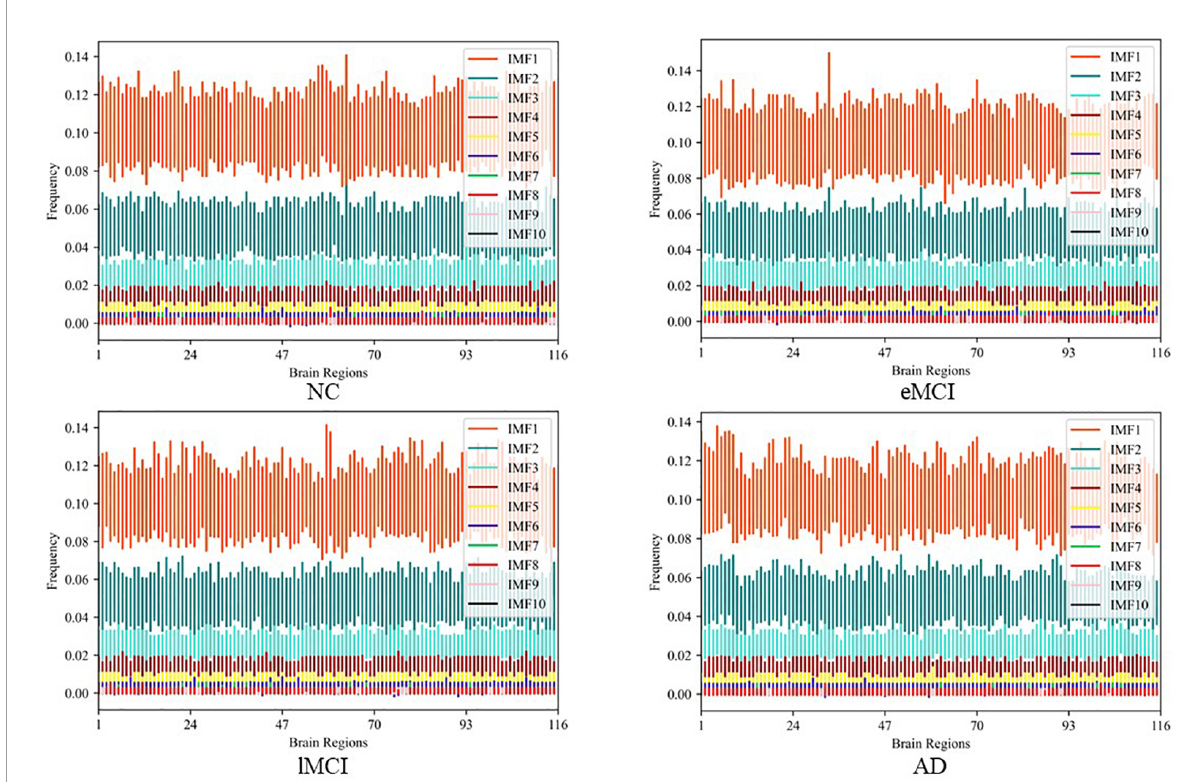
FIGURE3 The average frequency of intrinsic mode functions (IMF) components in every brain region in different